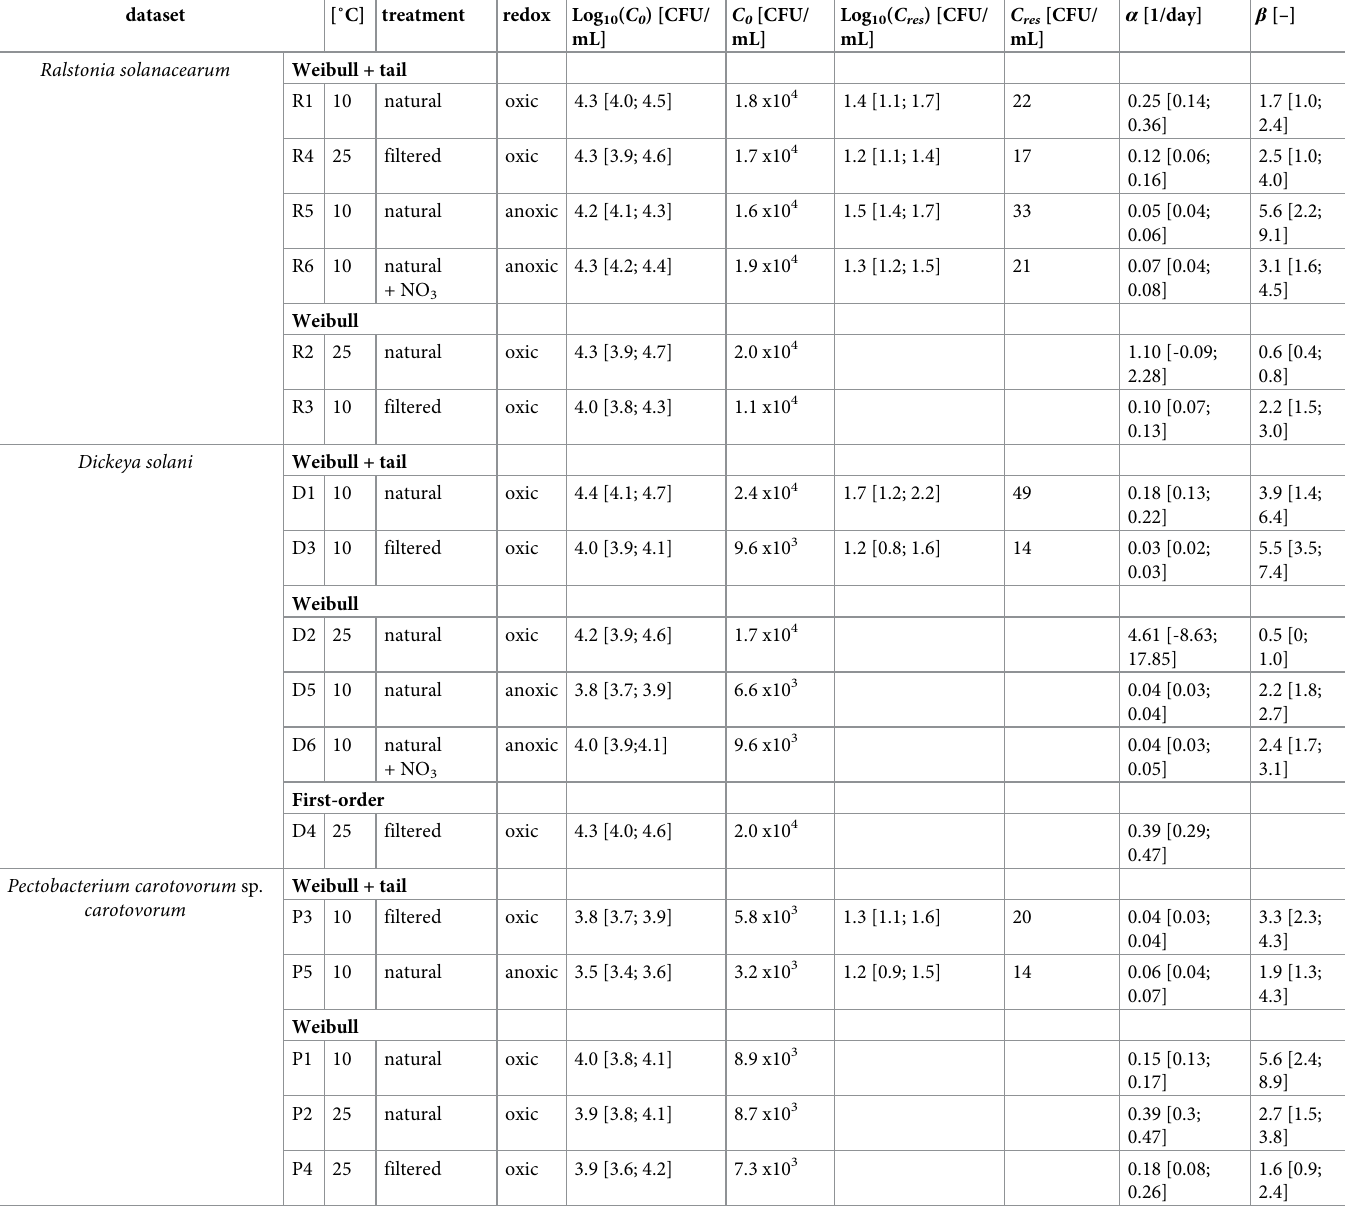
Table 3. Model parameter estimates and their 95% Gaussian confidence intervals shown in brackets.